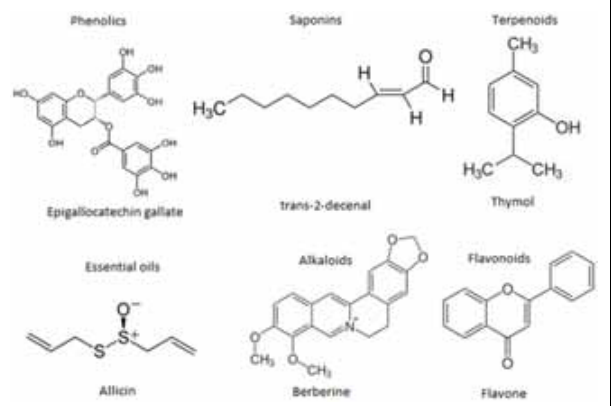
FIGURE 4 | Representative chemical structures of some antimicrobial phytochemicals. Phytochemicals like phenolics, saponins, essential oils, terpenoids, alkaloids, and flavonids are the major classes showed antibacterial